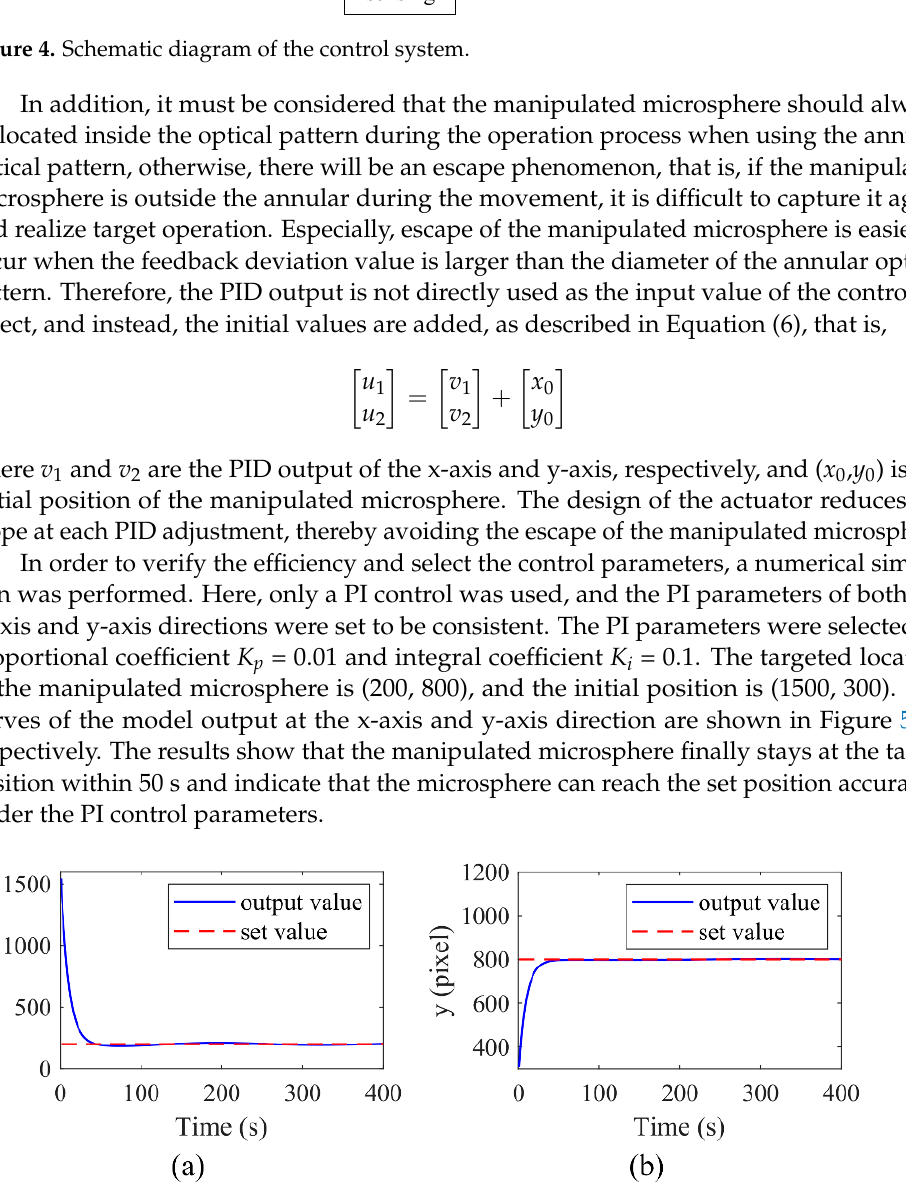
Figure 5. Numerical simulation results of the control system at the x-axis ( a ) and the y-axis ( b ), respectively.